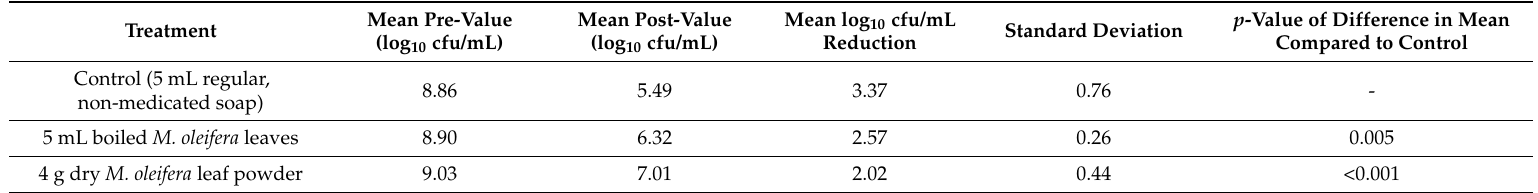
Table 2. Log 10 reduction of bacteria (cfu/mL) of different M. oleifera hand-washing treatments compared to